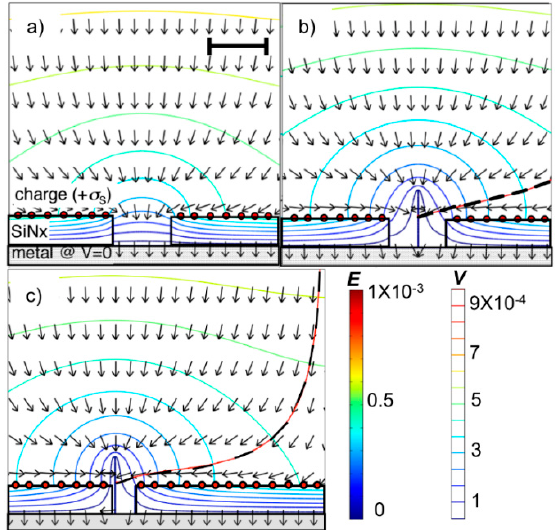
Figure 3. Finite element calculations of electric field for 50 nm deep vias in SiN x over metal with E = 10 3 V / m (contours are equipotential lines and arrows are the electric field): ( a ) 100 nm diameter via and σ S = 7.1 × 10 − 7 Coul / m 2 (annotated with red circles), ( b ) after deposition of 1 nm diameter by 100 nm long metallic nanotube at the center with the trace (dashed line) of a positively charged particle approaching a 350-nm radius from a line that is vertical to the center of the via. ( c ) Electric field and trace of positively charged particle approaching a 40 nm diameter via ( σ S = 7.1 × 10 − 7 Coul / m 2 ) with 1 nm diameter by 100 nm long nanotube attached to the metal at the base of the via. The legend for the electric field and equipotential applies to all figures. The scale bar in ( a ) is 100 nm and represents the magnification of all of the plots. Reprinted with permission from Goyal et al. [13]. Copyright 2008, American Vacuum Society.